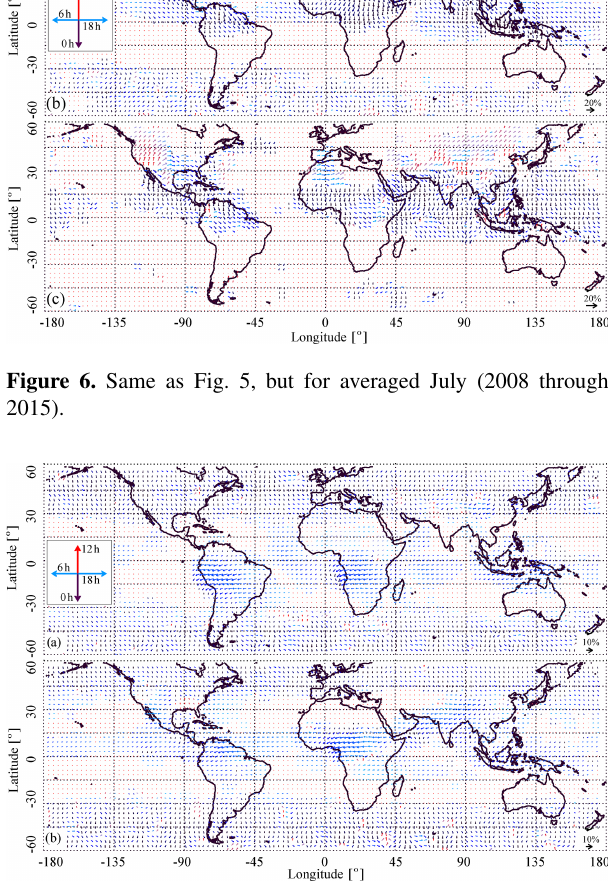
Figure 8. Regions selected for a more detailed analysis of the